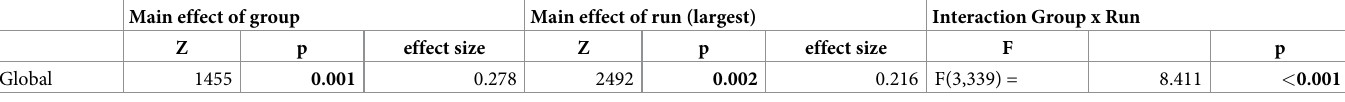
Bold font indicates statistical significance.